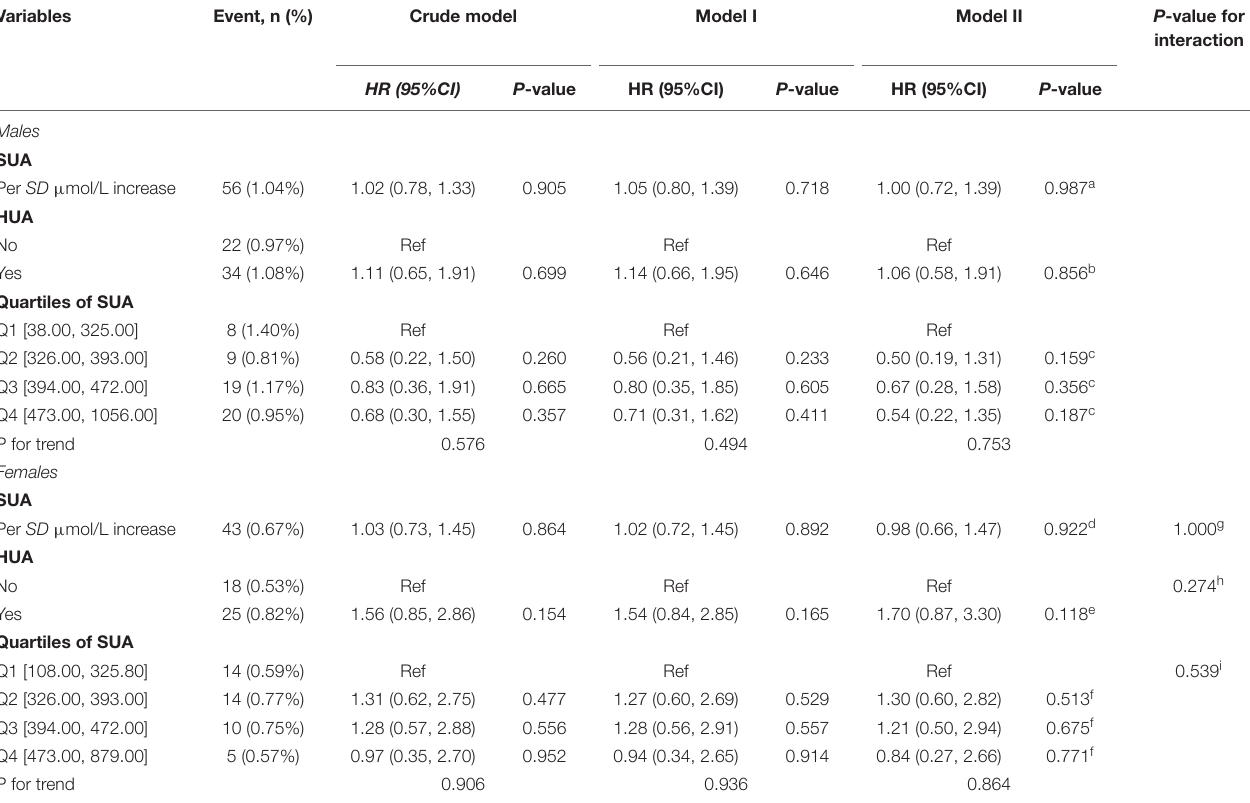
TABLE 5 | Hazard ratios of serum uric acid level categories for total first stroke events by sex in different models. Variables Event, n